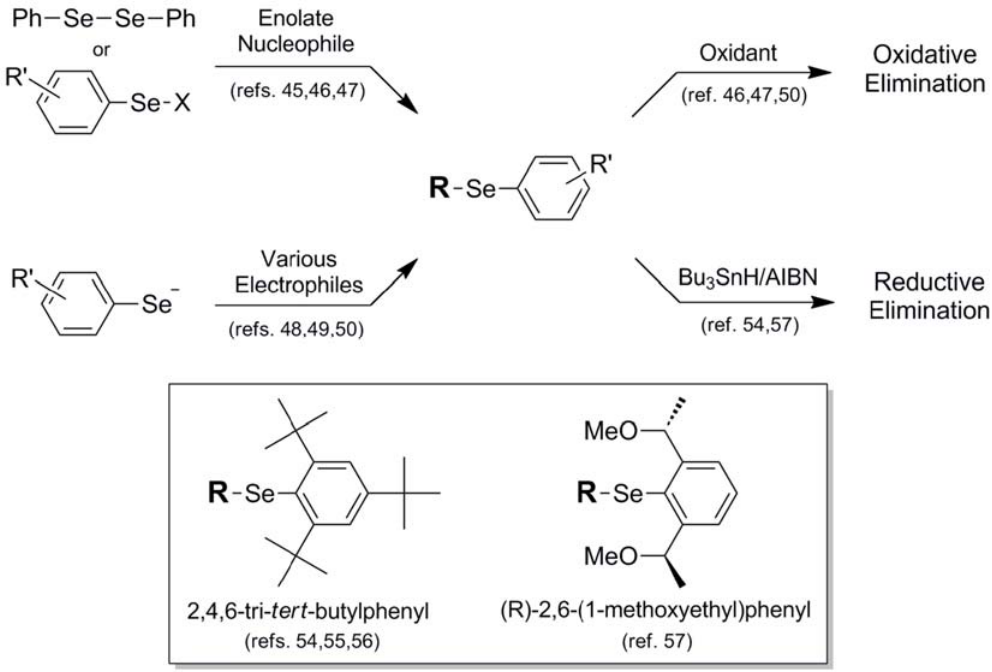
Figure 10. Synthetic routes into phenylselenyl protection schemes and their oxidative or reductive removal